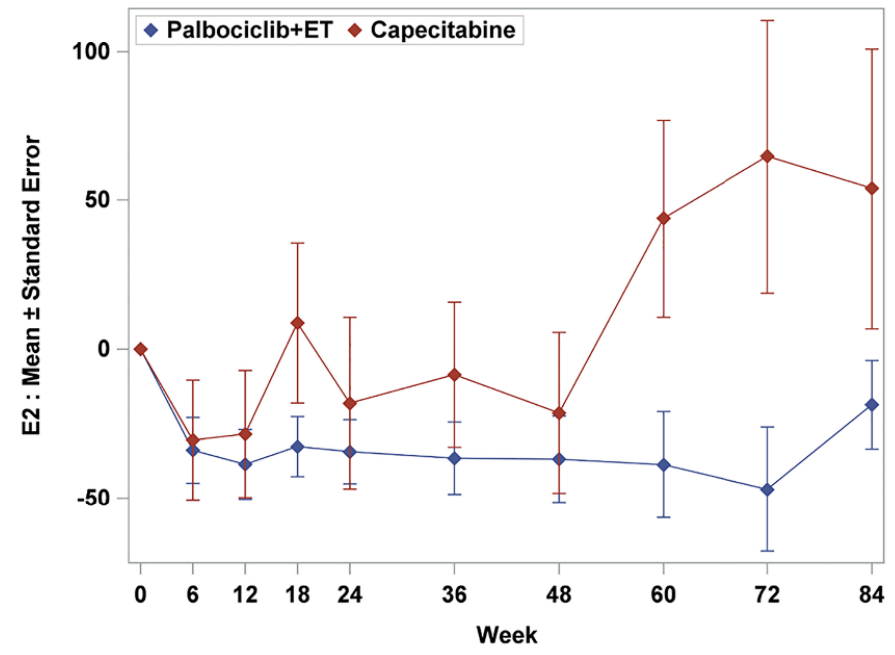
Figure 5. Estradiol change during the treatment.